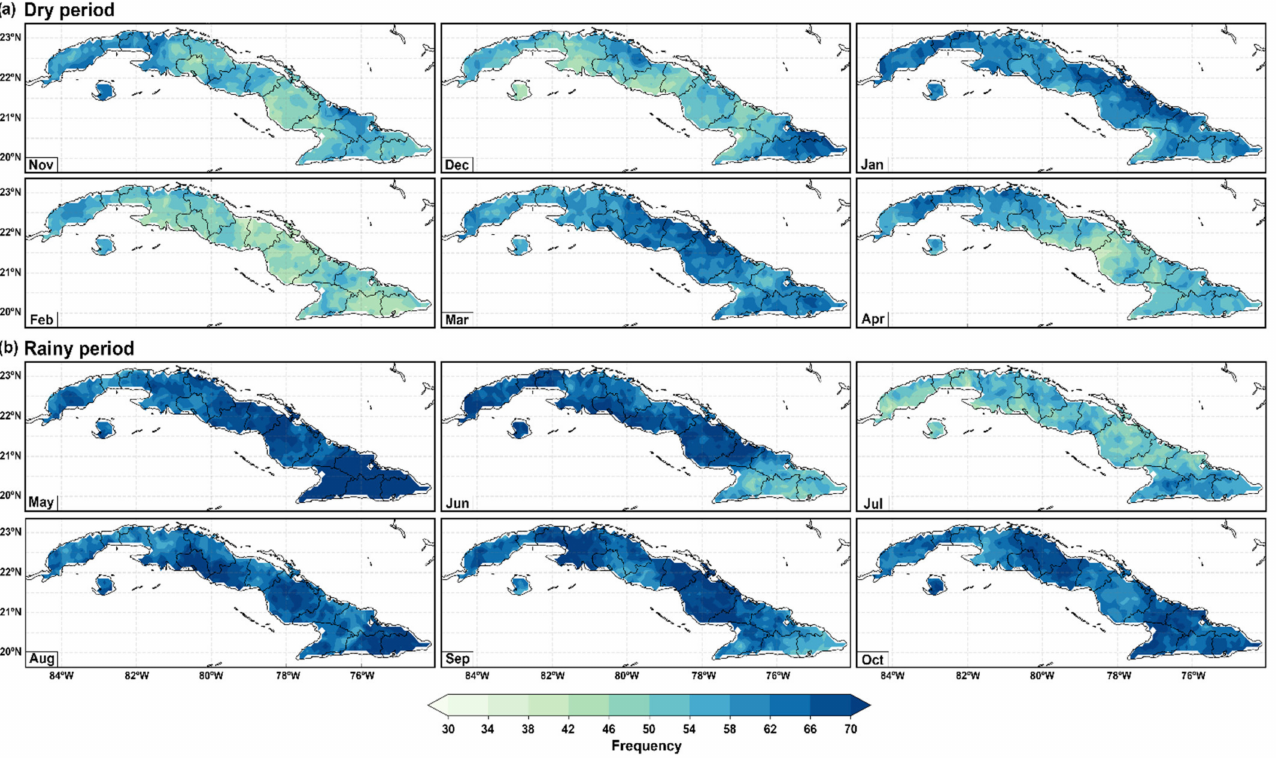
Figure 3. Monthly frequency of the number of days with daily precipitation above the percentile 95th for the months of the Dry ( a ) and Rainy period ( b ). Period from 1980 to 2019.